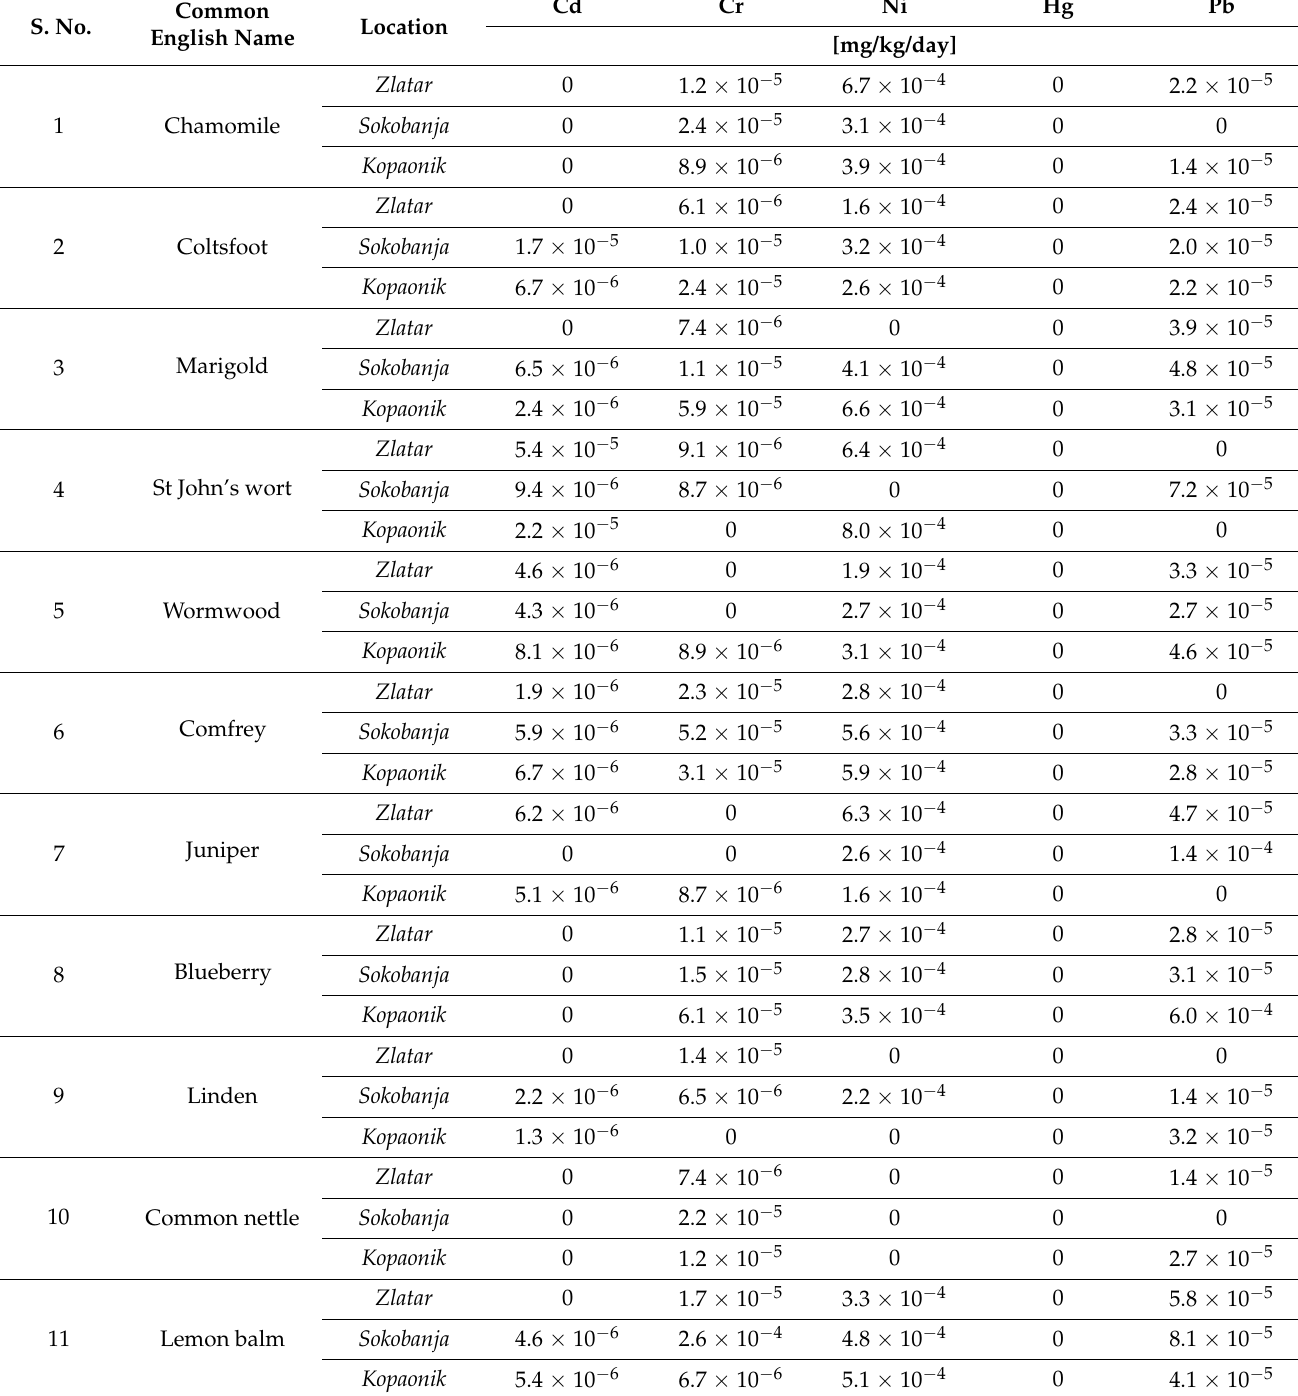
Table 6. The estimated daily intake ( EDI ) for Cd, Cr, Ni, Hg and Pb. S.